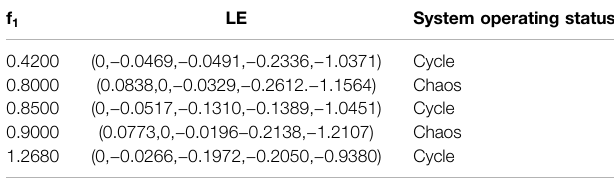
TABLE 3 | LE and system states at different f 1 values.